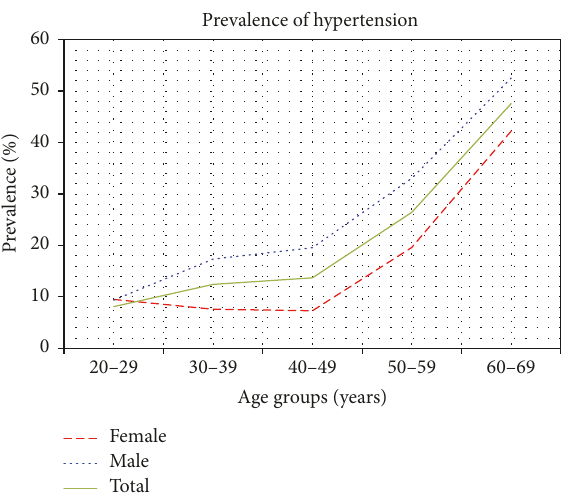
Figure1:Distributionofhypertensionprevalencebyagegroupsand